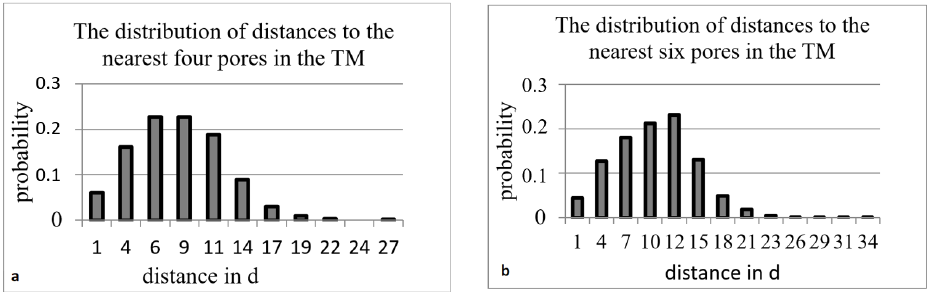
Figure 7. Theoretical (Formula (2)) and experimental distance distribution functions for TM with n = 10 6 cm − 2 and d = 4 μ m (Table 2).